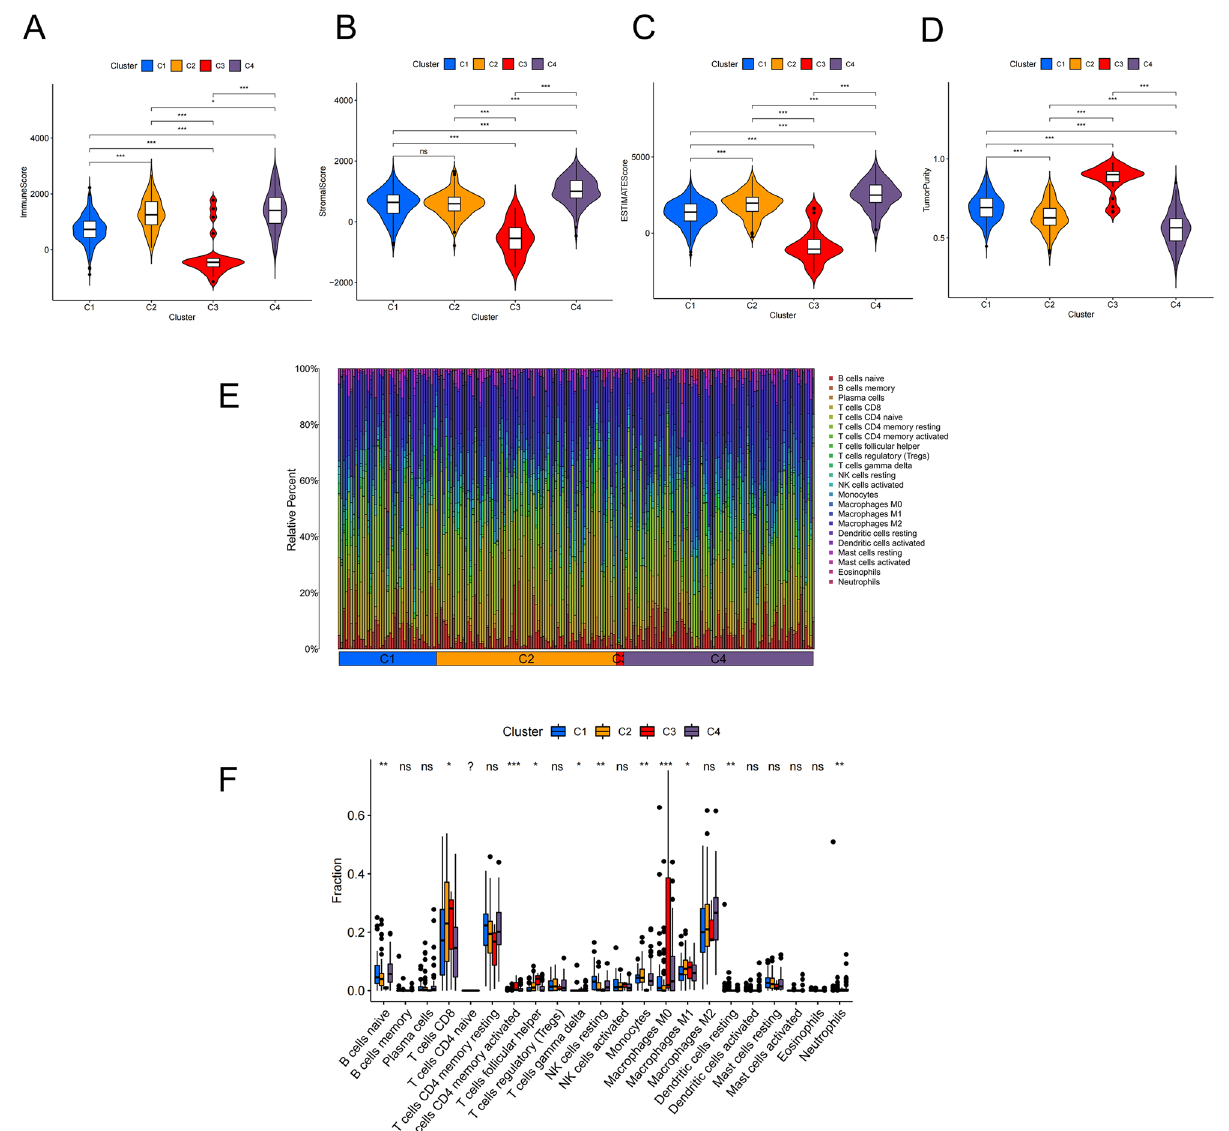
Figure 5. Comprehensive analysis of TME and TIICs in four molecular subtypes. ( A–D ) ImmuneScore, StromalScore, ESTIMATEScore, and tumor purity in four molecular subtypes. ( E ) The contents of 22 TIICs in each sample are displayed according to four molecular subtypes. ( F ) Differential expression analysis of TIICs in four molecular subtypes. (*P < 0.05, **P < 0.01, ***P < 0.001, ns: not